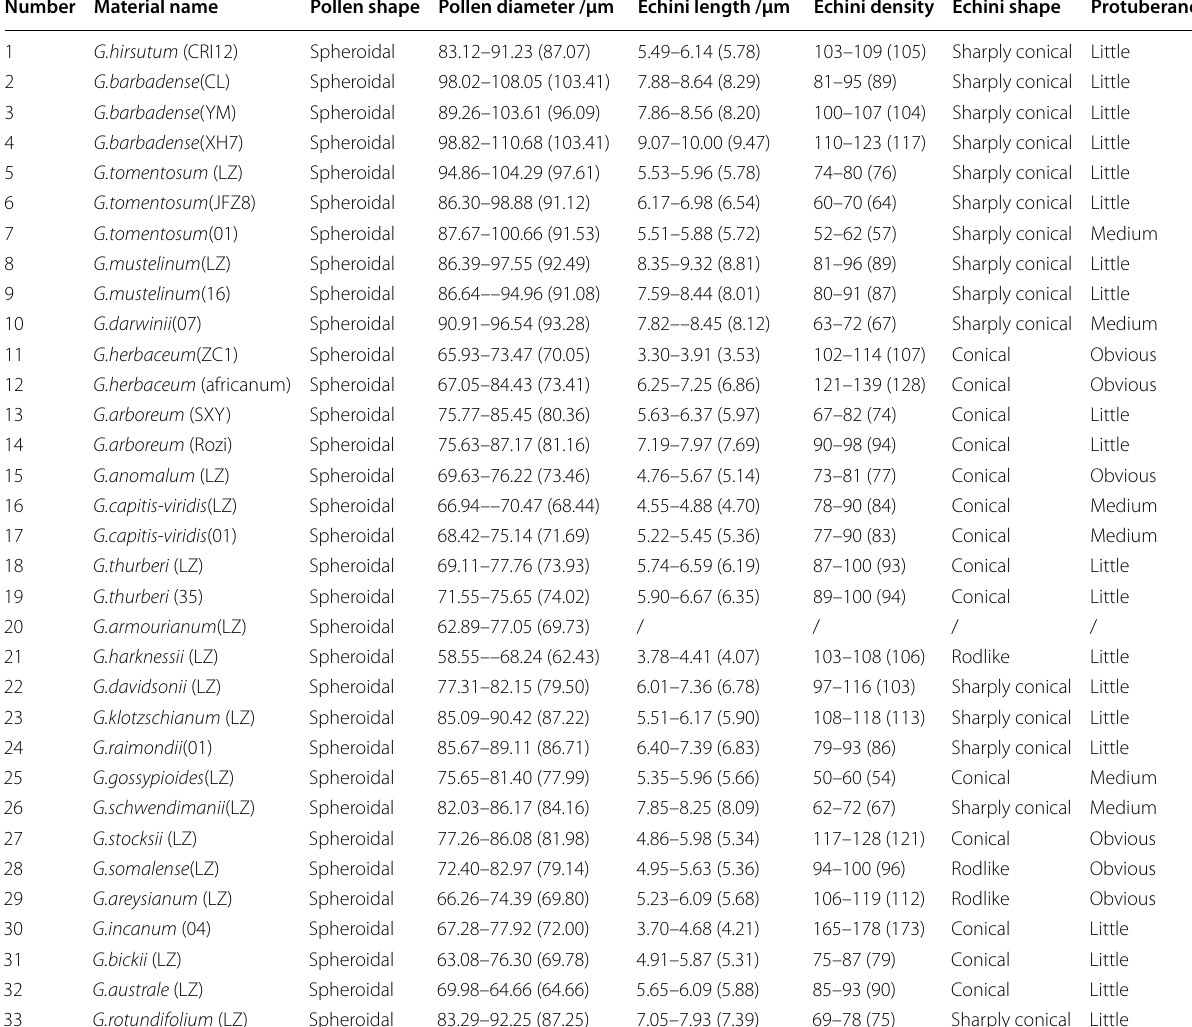
Table 2 Pollen morphologies of Gossypium